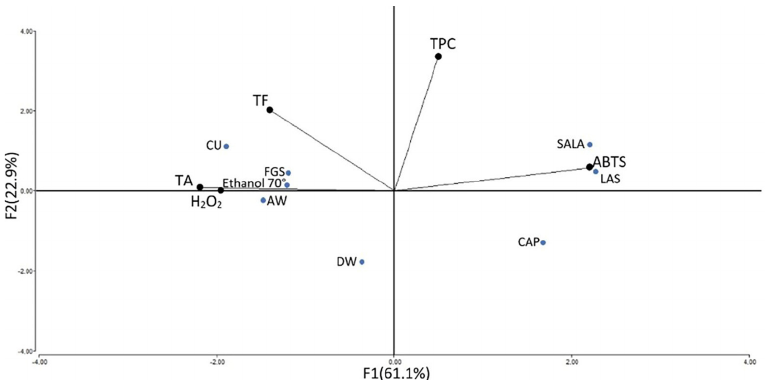
Figure 7. Main component analysis of the total phenolic content (TPC), total flavonoid (TF), and total alkaloids (TA) and antioxidant activity (ABTS, and H 2 O 2 scavenging activity) of extracts from